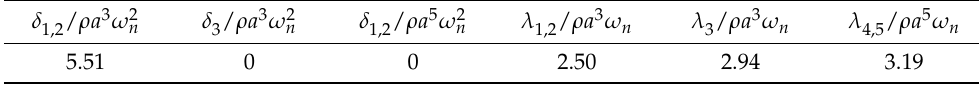
Table 1. Power take-off (PTO) characteristics. Table 1. Power take ‐ off (PTO) characteristics.